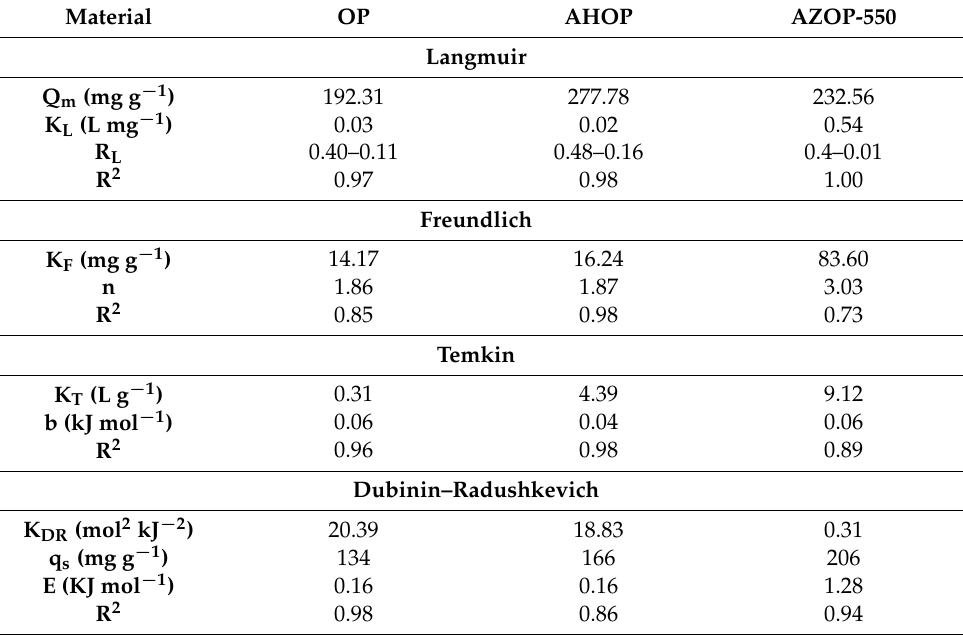
Table 3. Parameters for the different isotherm adsorption models for the adsorption of MB on OP, AZOP-550, and